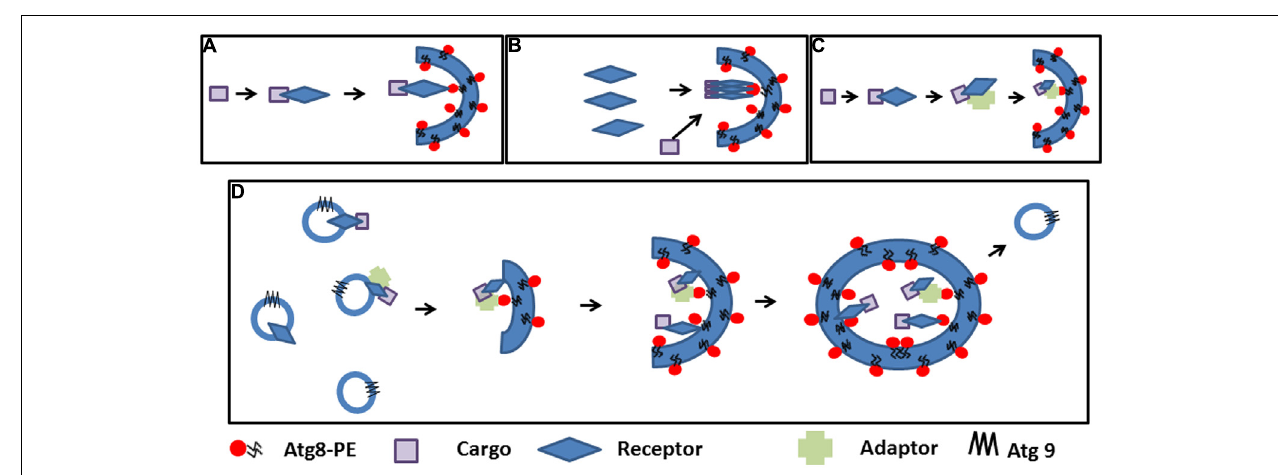
binds an adaptor before recruiting pre-existing phagophores though Atg8 interactions. (D) . Interaction between the receptor, the cargo (with or without an adaptor protein) nucleate the initiation of the phagophore and recruit the autophagy machinery; elongation of the phagophore and concentration of the cargo is achieved through Atg9-containing cycling